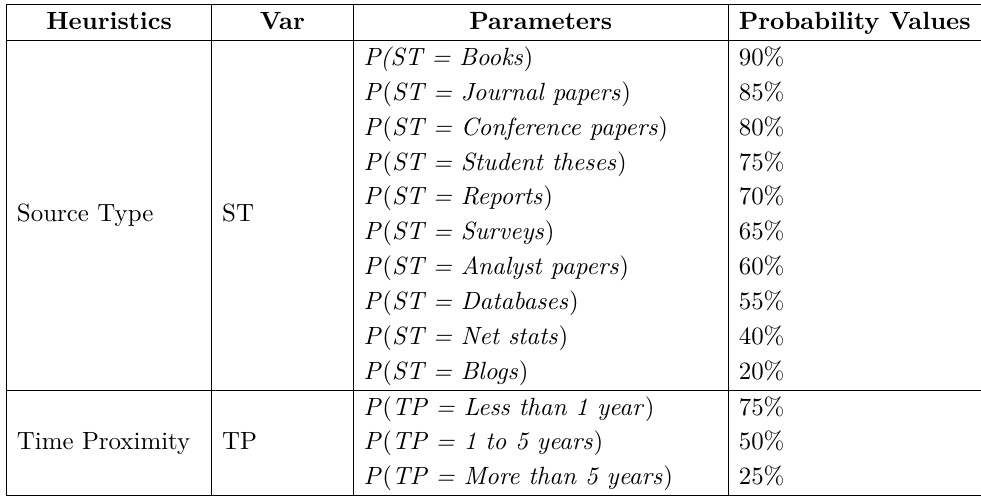
Table 1. Parameterized heuristics applied in this work Heuristics Var Parameters Probability Values P(ST = Books